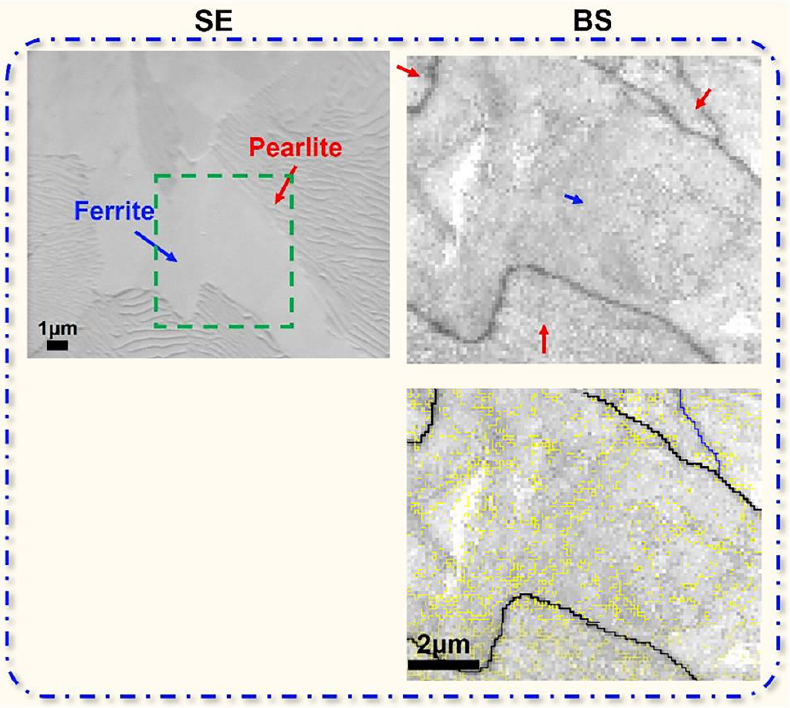
Figure 4. SE and BS maps showing the microstructure within the gauge length section of the sample fatigued at 391 MPa for 200,000 cycles. The EBSD mapping is taken from the area shown by the green dashed square area in the SE map. The blue arrows show the ferrite region, while the red arrows show pearlite areas. The two BS maps are identical. Only different coloring schemes are used. The top picture uses band slope coloring, whereas in the lower one, black lines show dislocation boundaries with misorientation angles of θ > 15°, yellow lines show dislocation boundaries with misorientation angles in the range of 0.7° < θ < 2° and blue lines show dislocation boundaries with misorientation angles of 2° < θ < 15°.